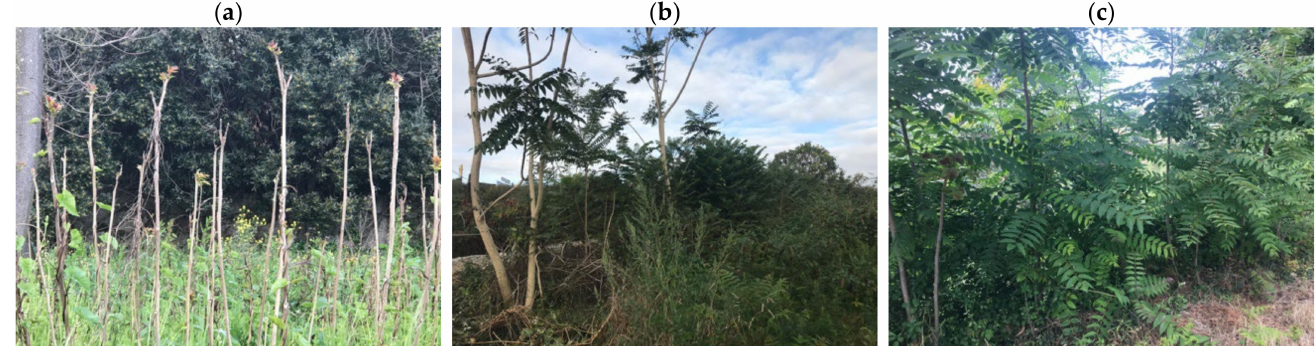
Figure 2. Occurrences of A. altissima : ( a ) resprouting 6 weeks after cutting, located in Guimar ã es (North Portugal); ( b ) adult specimens, located in Guimar ã es (North of Portugal); and ( c ) young specimens, located in Seia (Serra da Estrela,